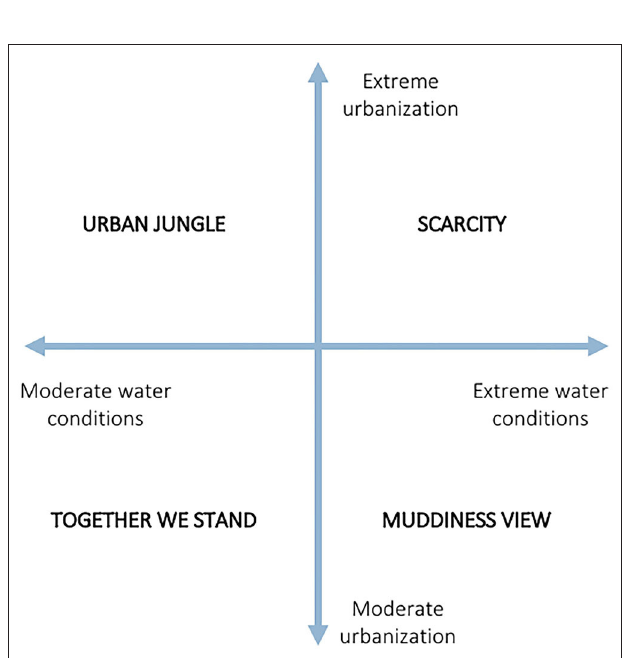
FIGURE 5 | Contextual scenarios for Khulna city in